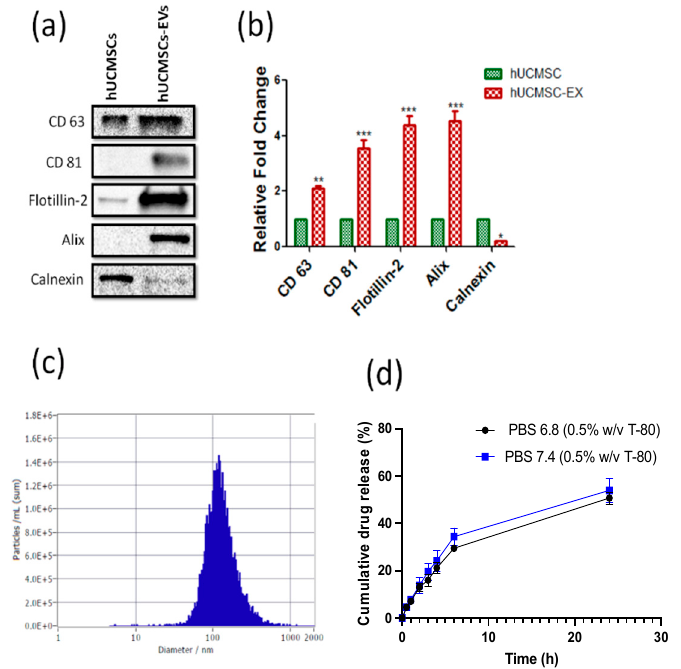
Figure 1. Isolation and characterization of CBD-loaded EVs (hUCMSCs): ( a ). Western blots, and ( b ). densitometric analysis of exosomal markers CD 63, CD 81, Flotillin-2, and stem cell marker; calnexin in human umbilical cord derived stem cells (hUCMSCs) lysates and extracellular vesicles protein lysates derived from hUCMSC (hUCMSCs-EVs). ( c ). Histogram represents the mean particle size distribution of CBD-EVs and ( d ). representative line plot showing % cumulative release of CBD from extracellular vesicles in PBS at pH 7.4 and 6.8, respectively, at different time points. (Statistical significance: *; p < 0.05, **; p < 0.01 and ***; p <